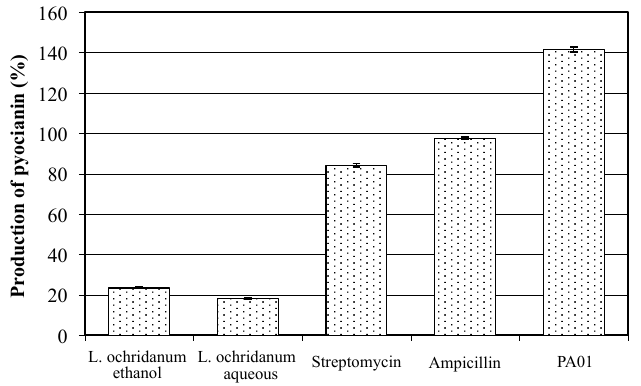
Fig. 2: Reduction of pyocyanin production of P . aeruginosa PAO1 by L . ochridanum extracts streptomycin and ampicillin tested at subMICs